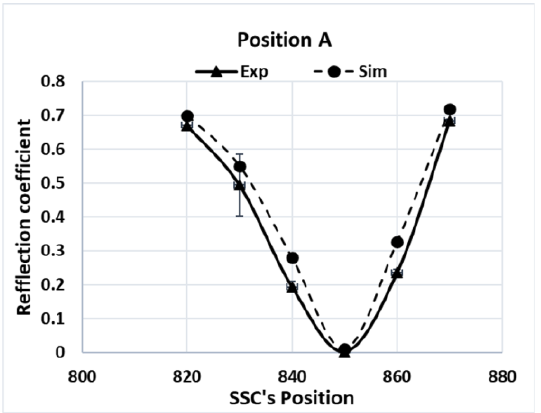
Figure 7. Reflection coefficients of pâté at position A for various SSC positions.